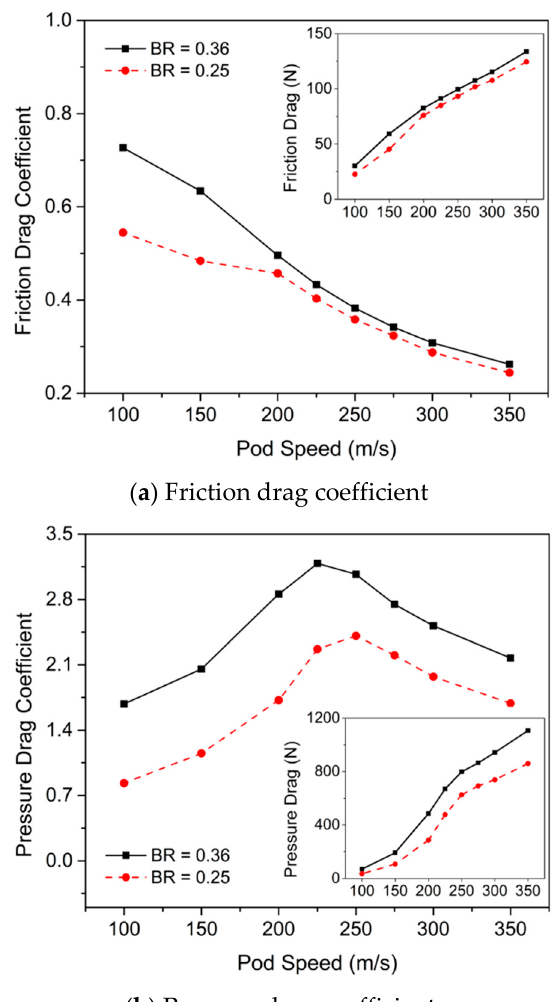
Figure 6. Variations of ( a ) friction and ( b ) pressure drag coefficients with pod speed and blockage ratio. Insets illustrate the variation of drag.